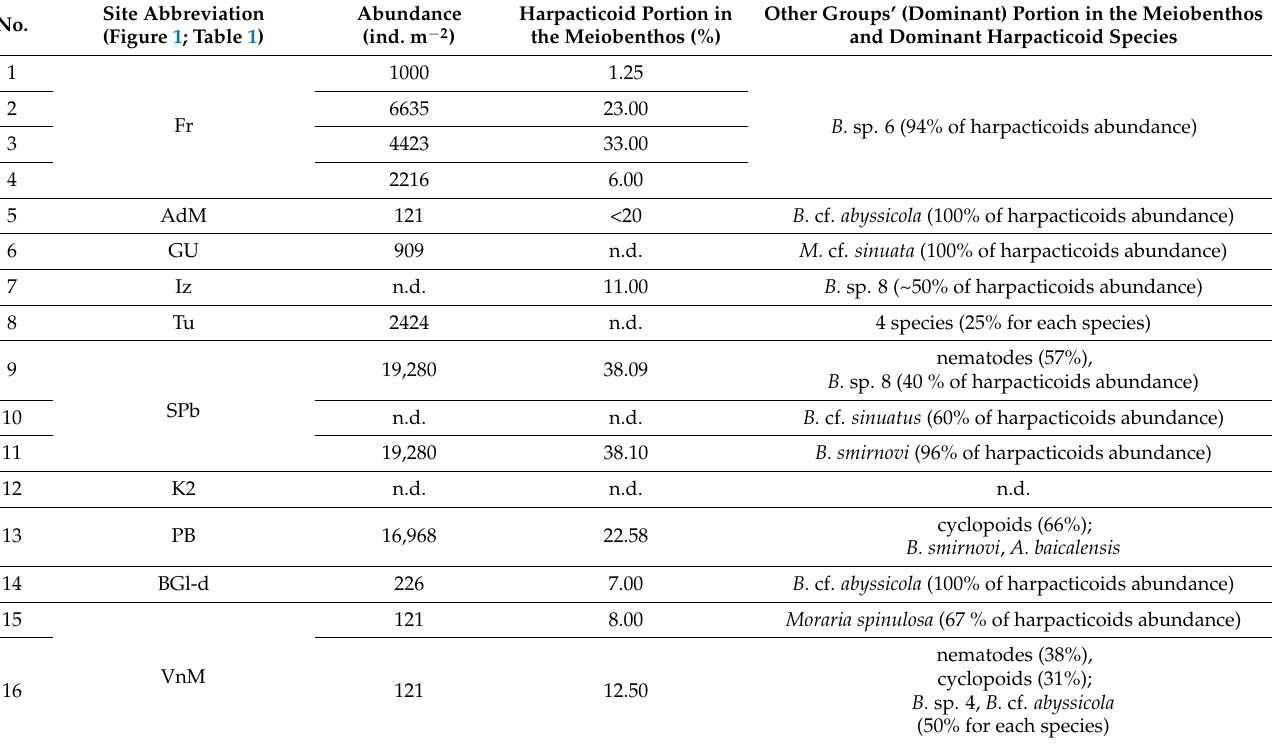
Table 4. Data regarding quantity of harpacticoids at the deep-water zone of Lake Baikal.